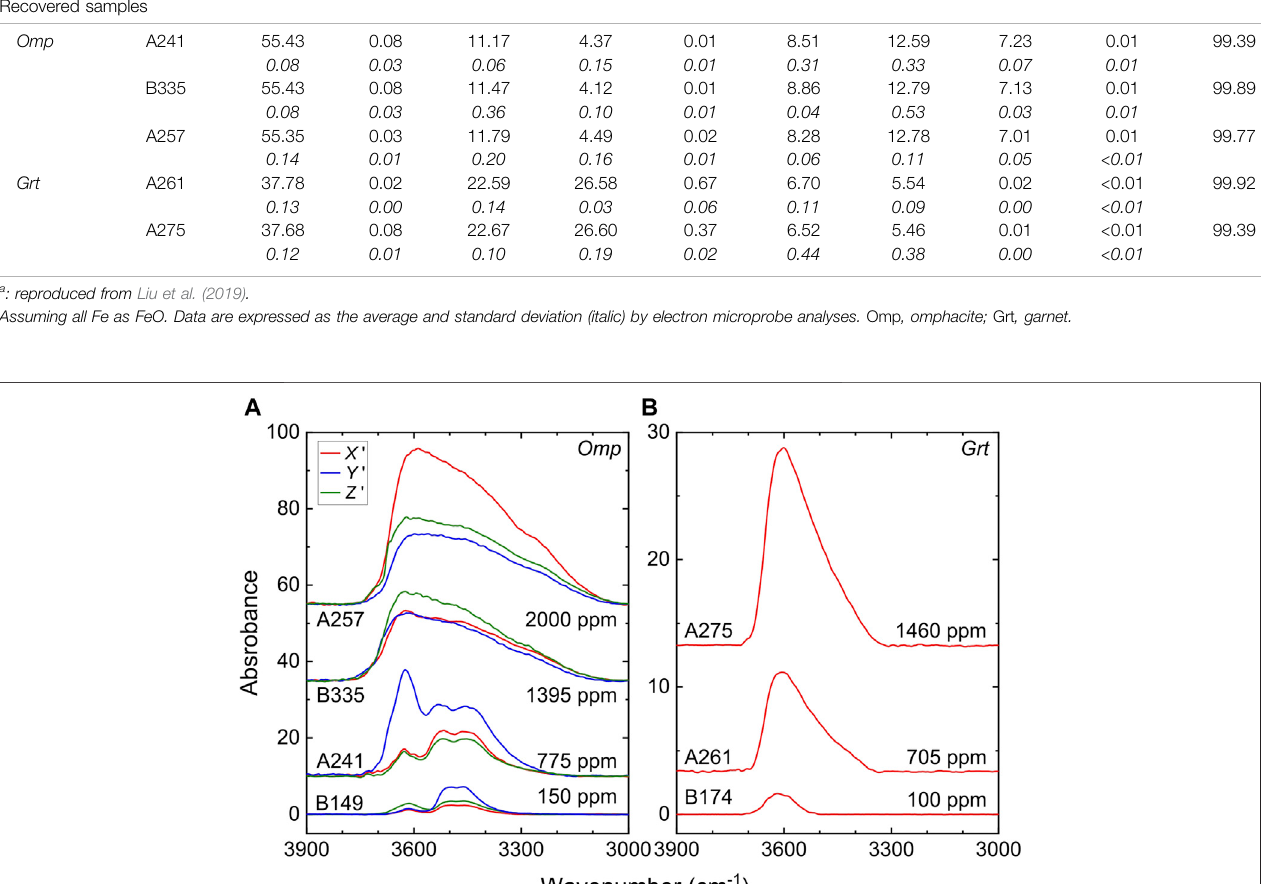
Frontiers in Earth Science |